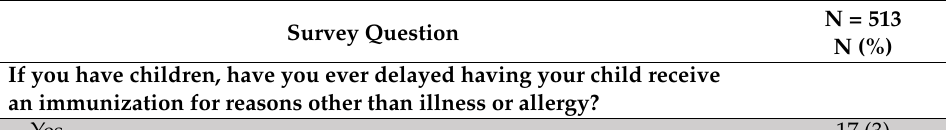
Table 2. Participant’s attitudes, knowledge and behavior regarding